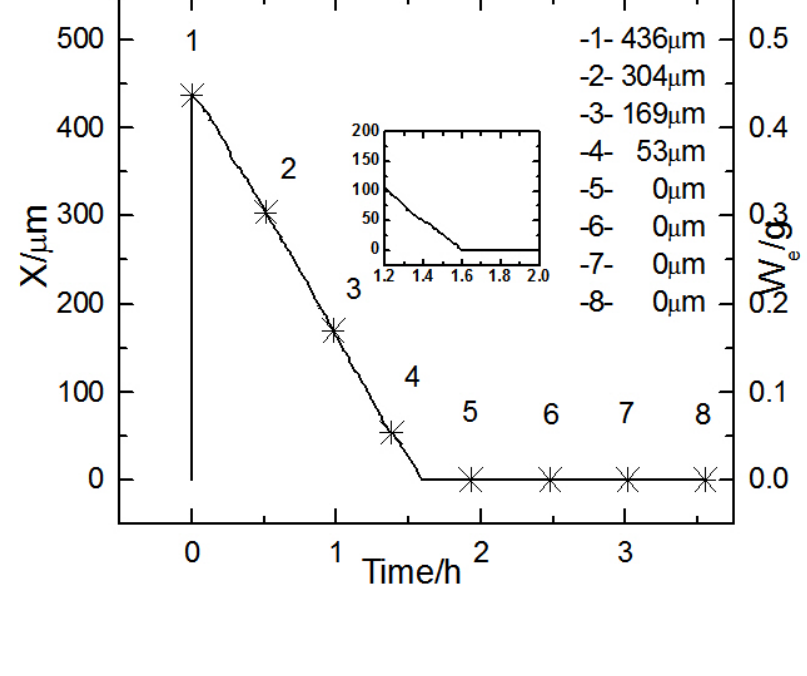
Figure 6. Plots of electrolyte film thickness X vs. time during 50 th cycle (rusted